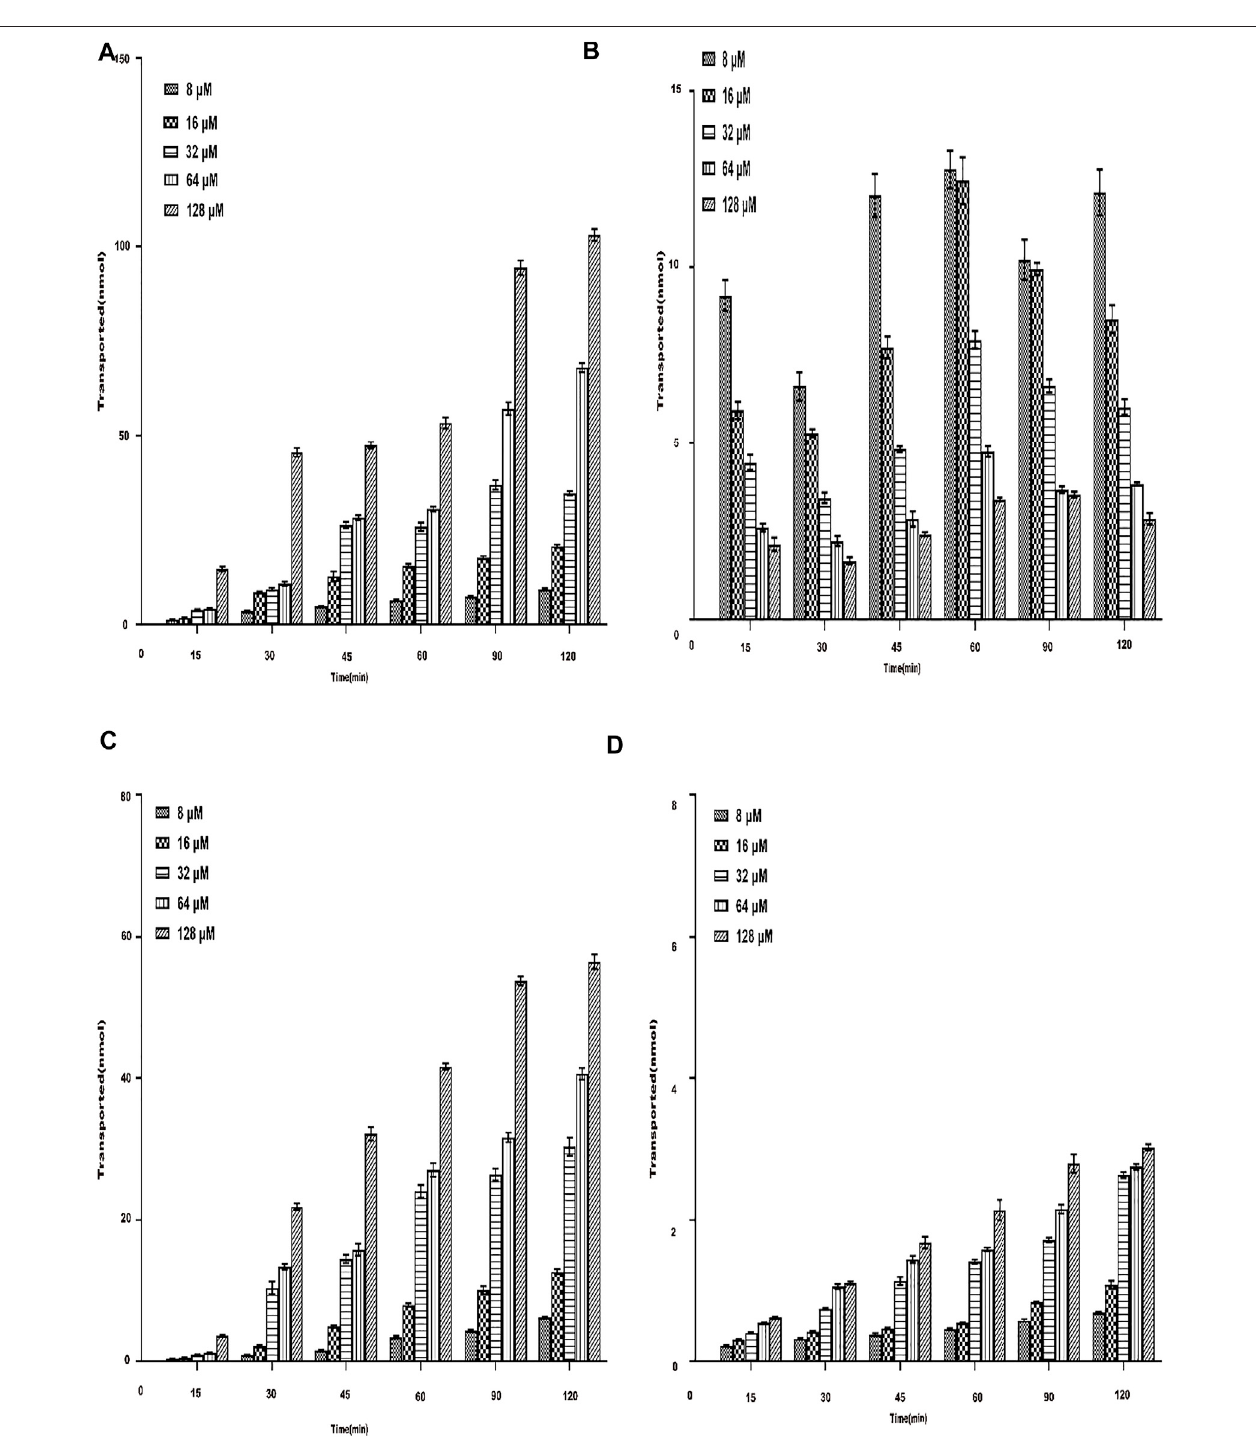
FIGURE 6 | Total transmembrane transport of AEE with different concentrations (8~128 μ M) on both sides of Caco-2 cells. The main active metabolite of AEE as salicylicacidrepresentedforAEEwasquanti fi edafteradministration. (A) AP-BLat37 ° C. (B) BL-APat37 ° C. (C) AP-BLat4 ° C. (D) BL-APat4 ° C.Valuesarepresentedas the means ± SD where applicable ( n = 6). * p < 0.05 than the BL side.